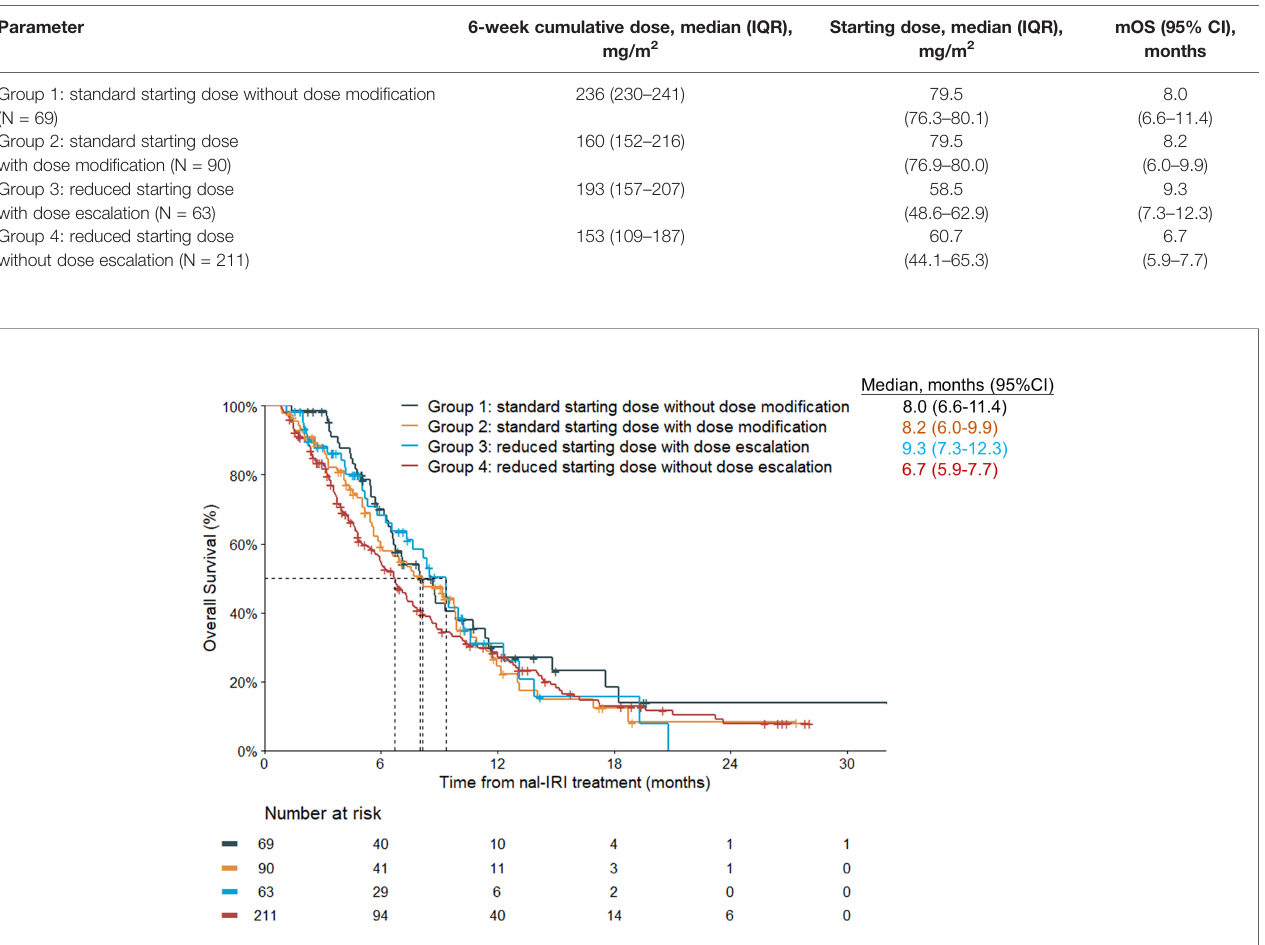
TABLE 4 | Dose distribution of different dosing pattern subgroups.